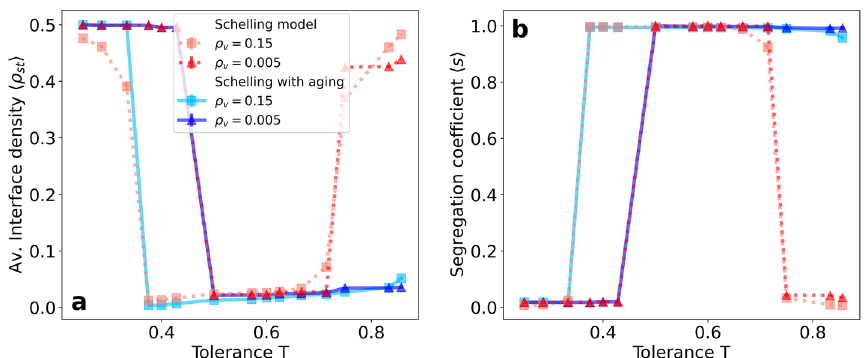
s ρ st Figure 1. Average interface density ( a ) and segregation coefficient ( b ) at the stationary regime as (cid:31) (cid:30) (cid:31) (cid:30) 0.5% and 15% . Results a function of the tolerance parameter T for two values of the vacancy density ρ v = are shown for both the Schelling model and the variant with aging introduced in this paper. Simulations are 80 lattice and averaged over 5 10 4 performed on an 80 × ·